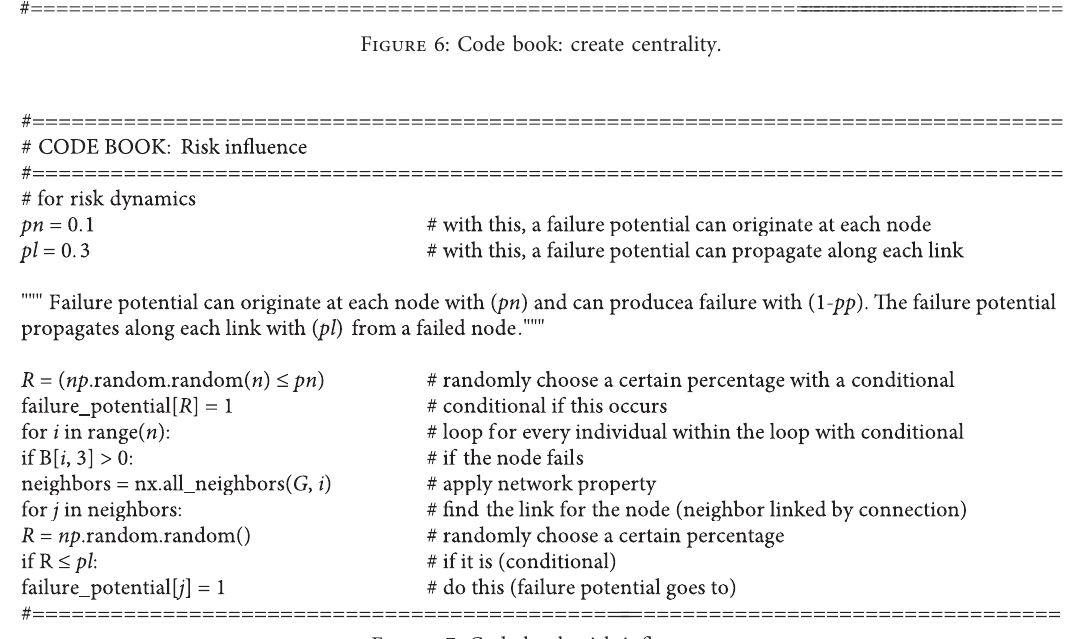
Figure 7: Code book: risk